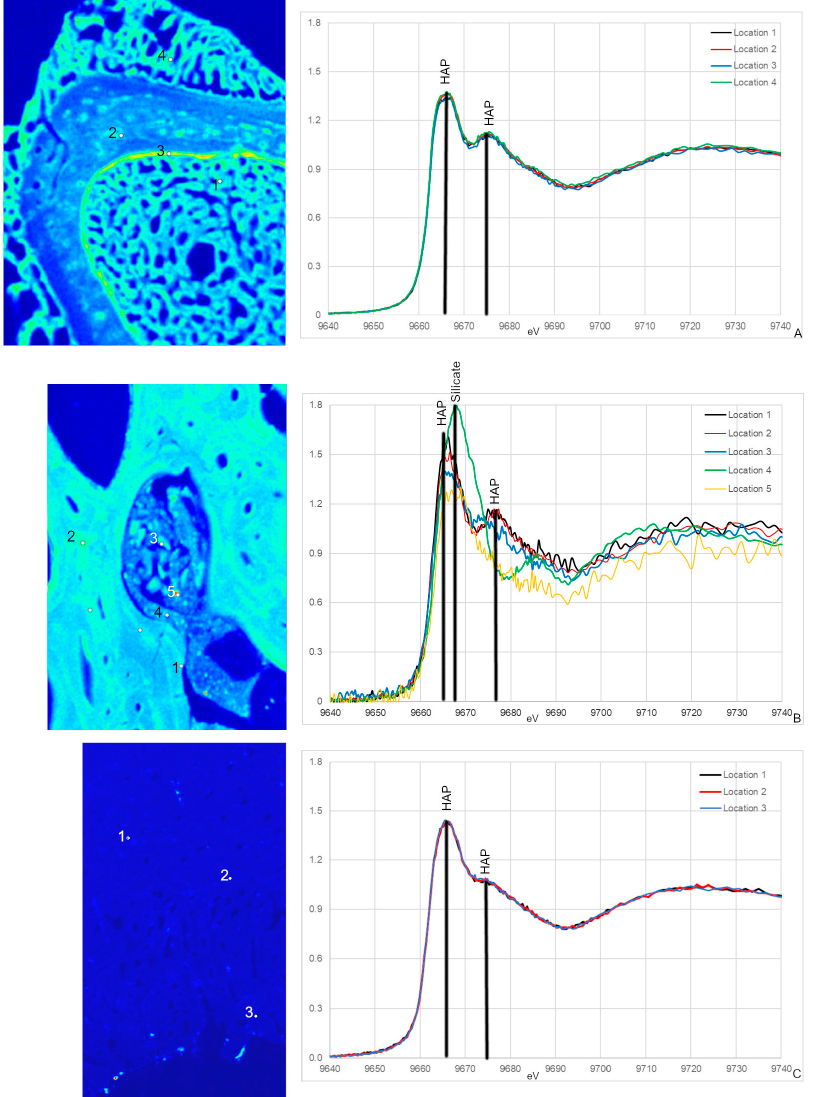
Figure 5. Zn XANES from NCSM 17977 ( C. moluccensis radius; ( A )), MOR 1125 ( T. rex femur; ( B )) and OMNH 34784 ( T. tilletti tibia; ( C )) and with peaks labeled using peak designations based on [54–56]. The locations for the XANES spectra are labeled on the corresponding Zn elemental maps. All spectra show peaks associated with hydroxyapatite (HAP) at ~9665 and ~9675 eV, respectively. For MOR 1125, an additional peak at 9678 eV in spectrum 4 is associated with silicates. Zn XANES spectra from OMNH 34784 are similar and only exhibit peaks for HAP at ~9665 and ~9675 eV (5C). Both HAP peaks are broader compared to NCSM 17977 and MOR 1125, with the second peak at ~9675 eV reduced to almost a